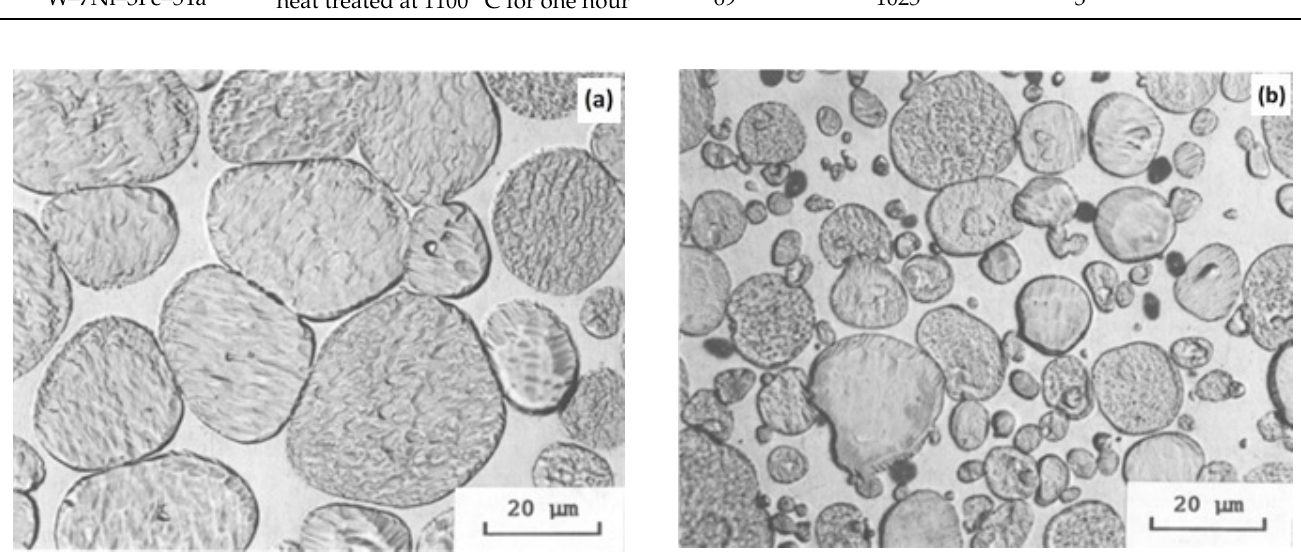
Figure 3. Microstructure of ( a ) 90W–7Ni–3Fe and ( b ) 85W–7Ni–3Fe with 5 wt% of tantalum, showing grain refinement and the presence of porosity [52]. Reproduced with permission from Bose and German, Metallurgical Transactions A; published by Springer, 1988. Table 2. Mechanical properties of the rhenium and tantalum added to the tungsten heavy alloy of W–Ni–Fe.